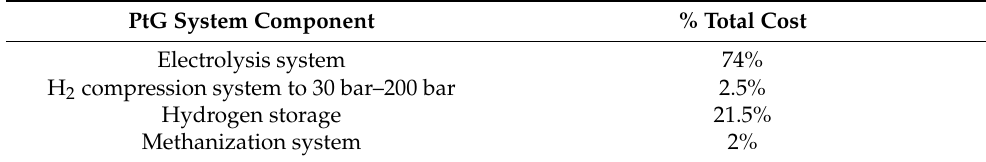
Table 4: Table 4. Cost for large-scale PtG plants, adapted from